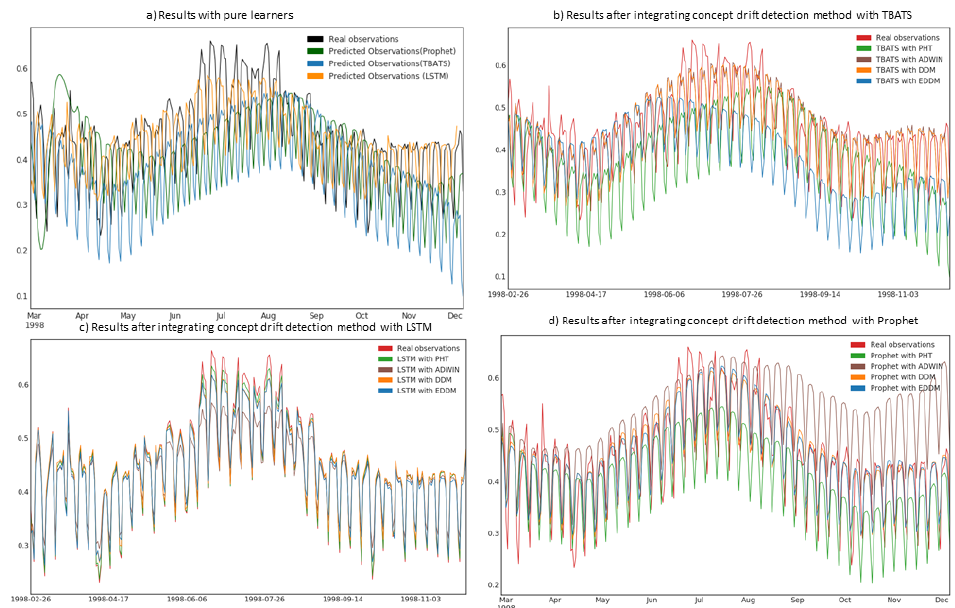
Figure 5. Prediction results from time series learners (see Section 3) for ELEC2 [73], where X axis shows DateTime and Y axis the value. Figure ( a ) shows results from pure learners, where figures ( b – d ) show results after integrating concept drift methods.